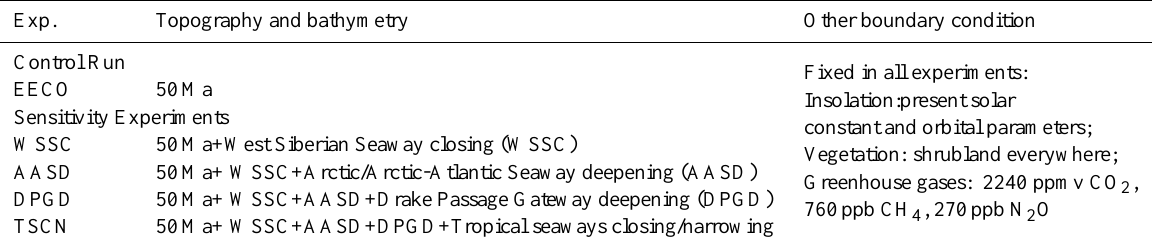
Fig. 2. Atlantic meridional overturning streamfunction (Sv) simulated in the experiments. (a) Early Eocene land-sea distribution (land is yellow) with changes in seaways highlighted in blue and red. (1) closing of the West Siberian Seaway (WSSC); (2) deepening of the Arctic/Arctic-Atlantic Seaway (AASD); (3) deepening of the Drake Passage Gateway (DPGD); (4) constriction of the tropical Atlantic seaways (TSCN), with a fully closed Tethys seaway and narrow Central American seaway. Simulation in the control (b) EECO and the sensitivity experiments (c) WSSC, (d) AASD, (e) DPGD, (f) TSCN.